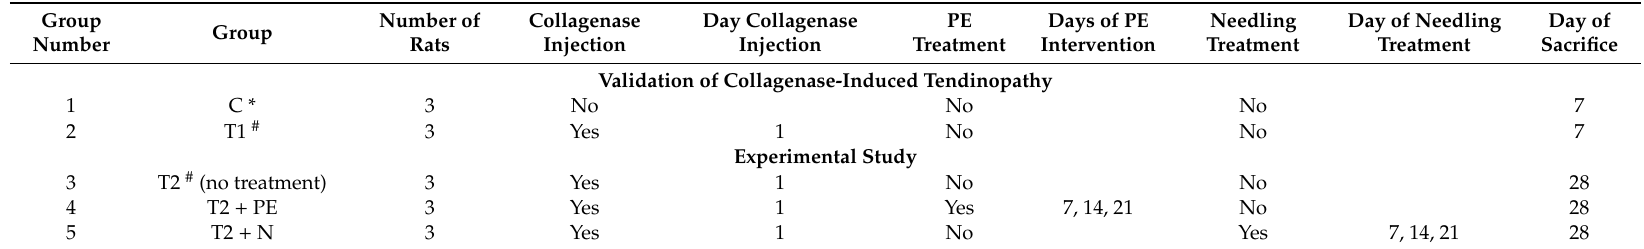
Table 1. Random Distribution of Rats with Experiment Procedures by